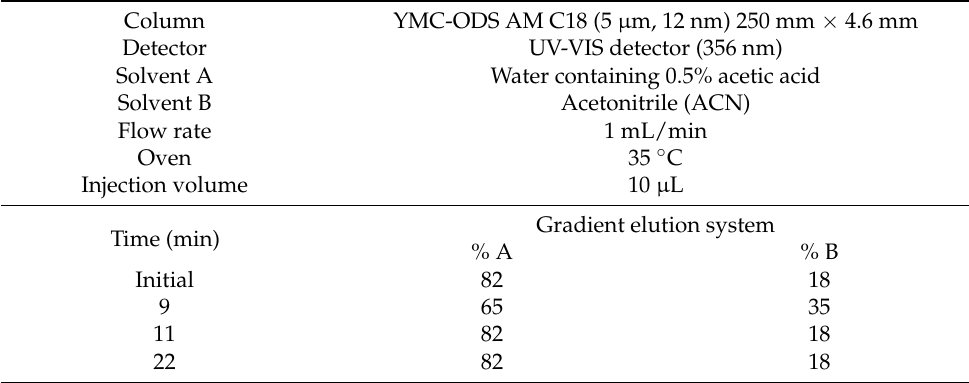
Table 2. The HPLC analysis